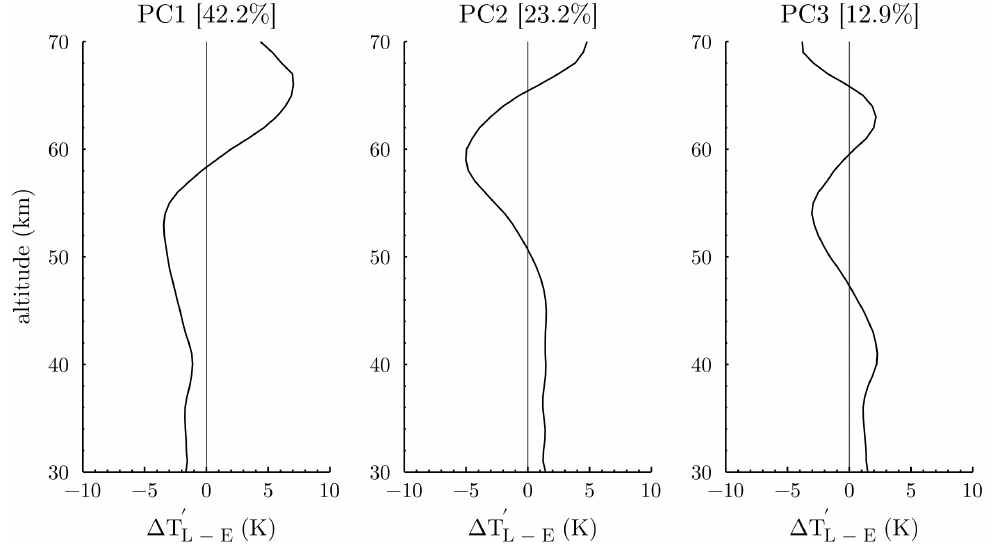
Figure 7. Vertical modes for the winter months (December, January, February) of the fluctuations of the temperature difference between the LiDAR and ERA-5, corresponding respectively to (PC1) 42%, (PC2) 23%, and (PC3) 13% of the